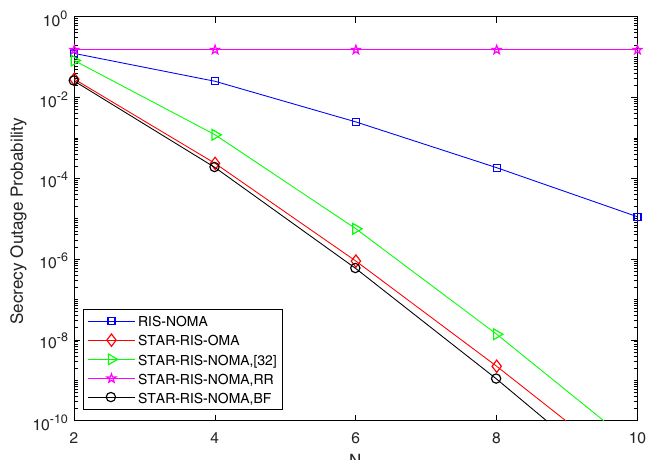
Fig. 4 The SOP versus the different number of columns on STAR-RIS for different schemes. the SOP of the proposed scheme versus four other